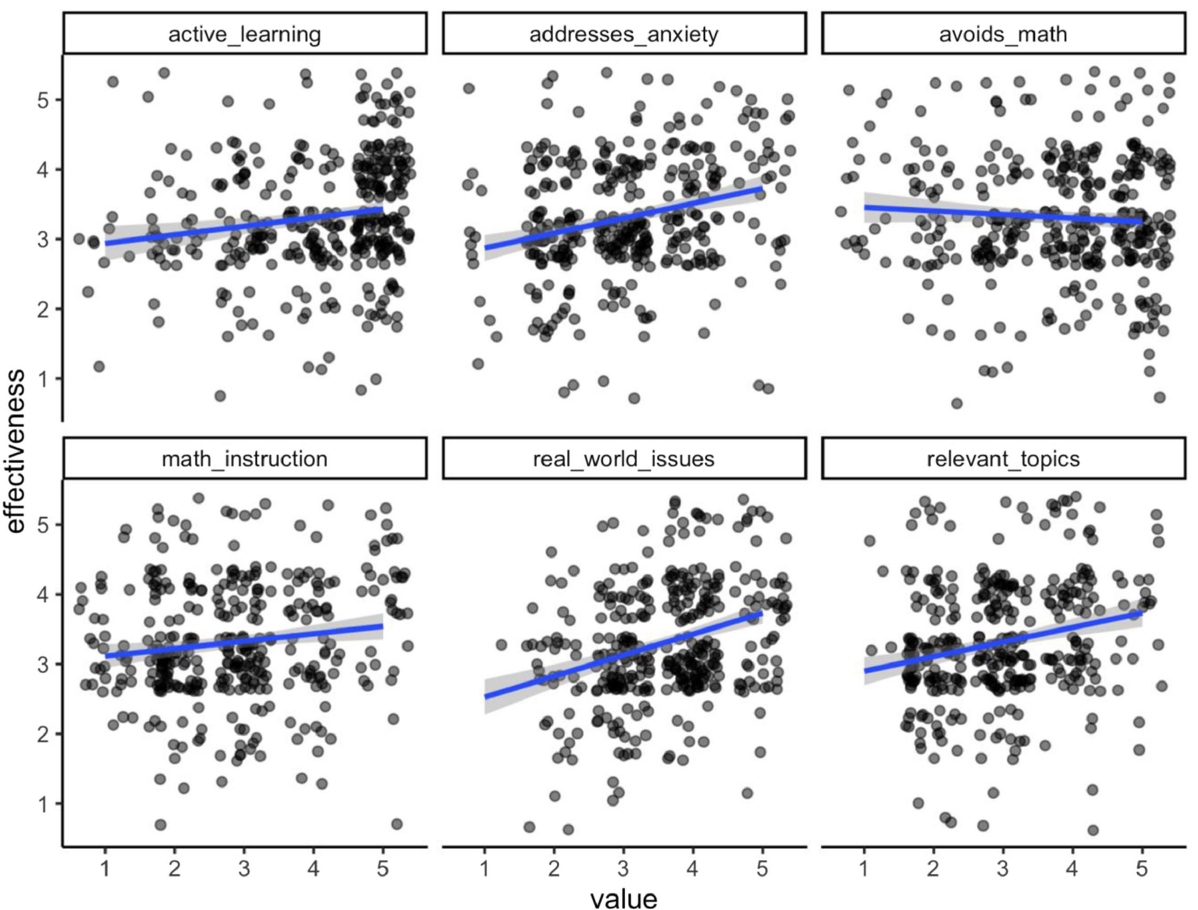
FIG. 4. Associations between lecture teaching strategies and perceived course effectiveness in engaging students.